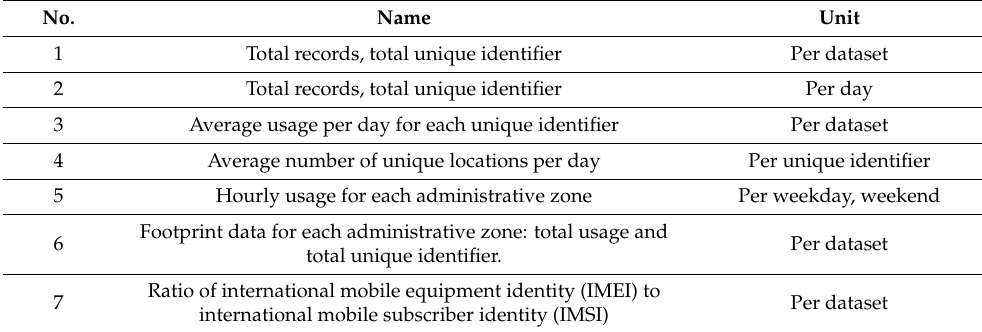
Table 4. The statistical data for data quality